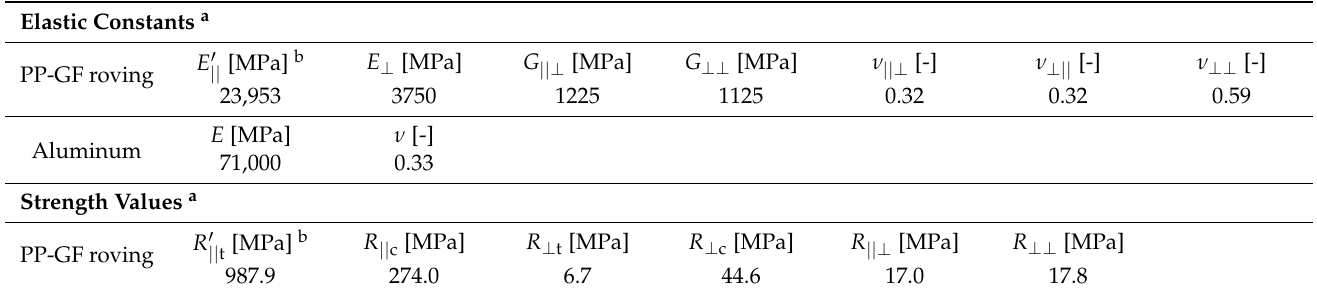
Table 1. Elastic constants and strength values used in the FE simulations, adapted from